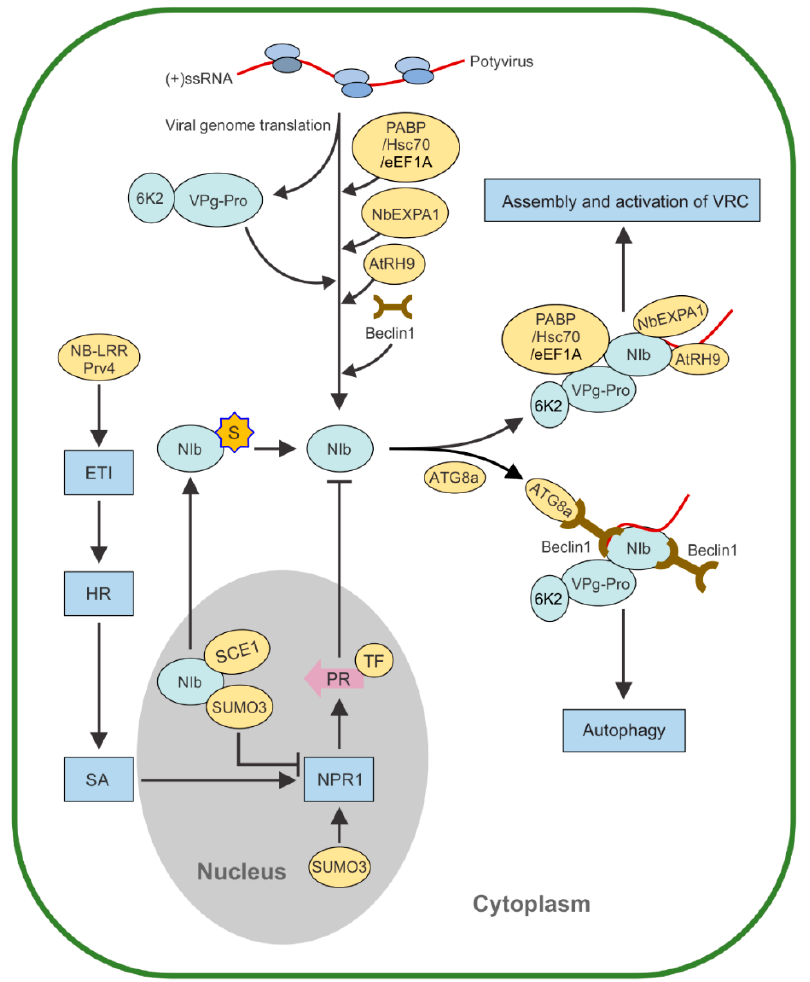
Figure 2. NIb plays contrasting roles in potyvirus infection. After entry into host plant cells, a potyvirus virion undergoes disassembly of viral particles and viral genome translation to produce viral proteins required for replication. The 6K2 or its precursor remodels the ER to form the VRC-containing vesicles at ER exit sites for potyvirus genome replication. The 6K2-induced vesicles may subsequently target chloroplasts for robust viral replication. NIb is recruited to the VRC, likely via its interaction with VPg domain of 6K2-VPg-Pro. NIb recruits many host factors such as poly(A)-binding protein (PABP), eukaryotic elongation factor 1A (eEF1A), heat shock cognate 70-3 (Hsc70-3), A. thaliana RNA helicase AtRH9, and N. benthamiana α -expansin (NbEXPA1). Potyvirus infection activates autophagy in plants and Beclin1 (ATG6) interacts with NIb to directly inhibit NIb activity or mediate autophagic degradation of NIb to restrict virus infection. Beclin1-mediated NIb degradation requires a key autophagic adaptor protein, ATG8a, which targets to Beclin1 to facilitate the docking of the Beclin1–NIb or Beclin1–NIb–VRC complex to autophagosomes. NIb may also act as an avirulence factor to activate ETI by recognition of resistance gene R-encoded proteins such as Pvr4. In addition, the nuclear-localized NIb is sumoylated by SUMO3. The sumoylation of NIb promotes potyvirus infection by relocalization of NIb from the nucleus to the cytoplasm and inhibition of the SUMO3-activated-NPR1-mediated resistance pathway.